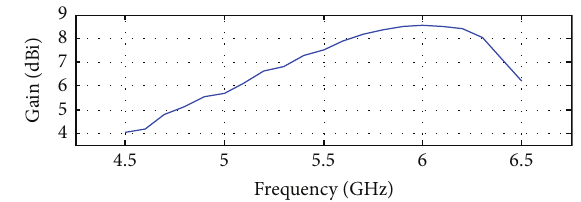
Figure 13: Computed antenna gain versus